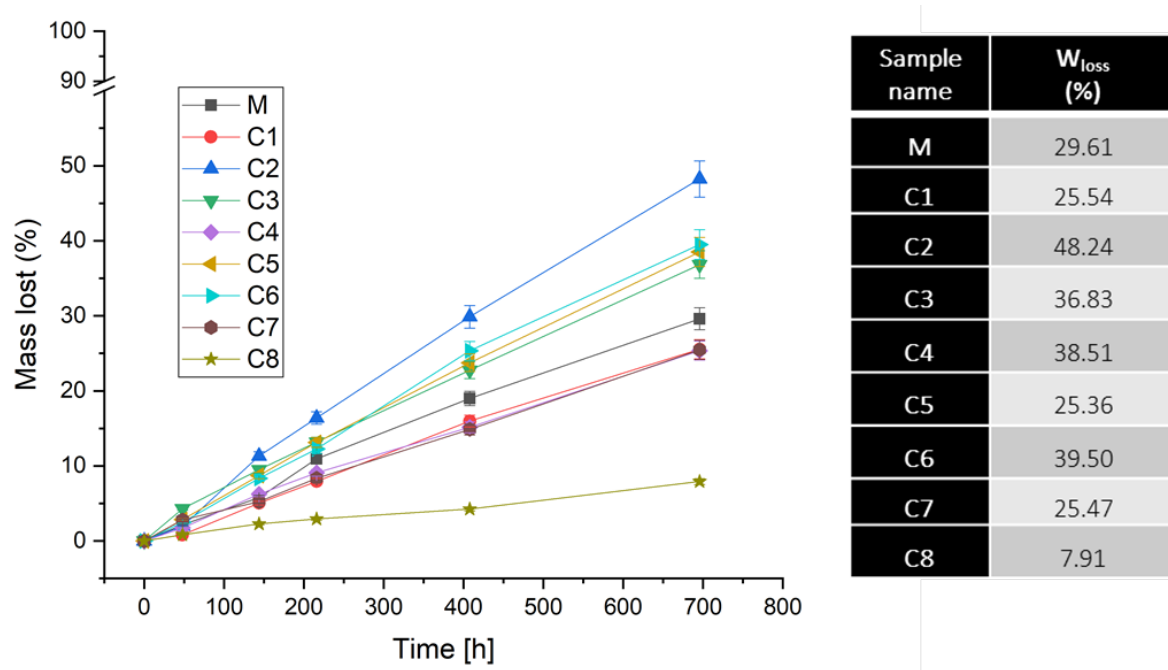
Figure 1. The solubility of powder glass before and after 14 days immersion in 10 mL deionized water.